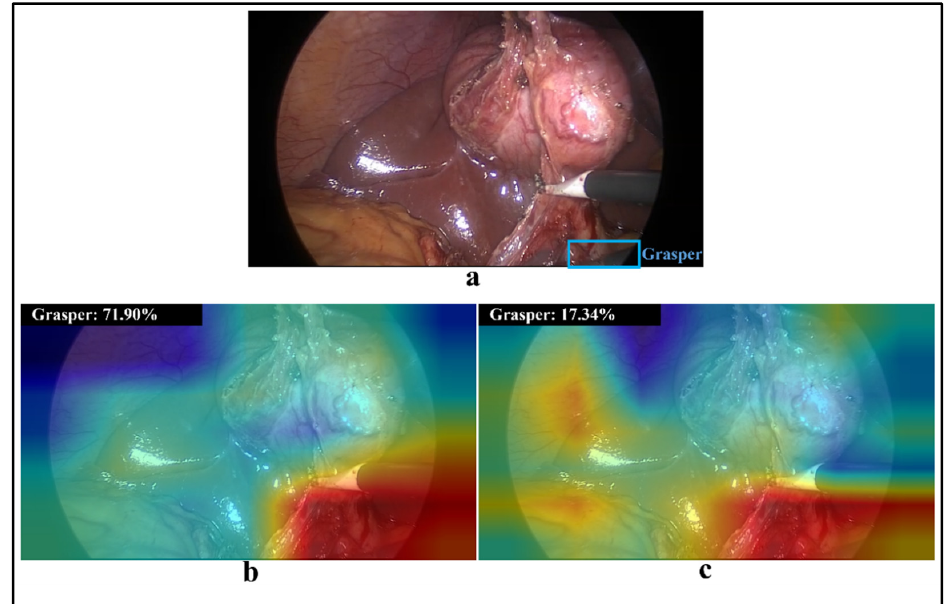
Figure 5. ( a ) A laparoscopic image containing a hook and a partial grasper (in blue box); ( b , c ) visualisations of class activation maps and prediction probability for class grasper obtained by CNN-80S and CNN-40S models, respectively.